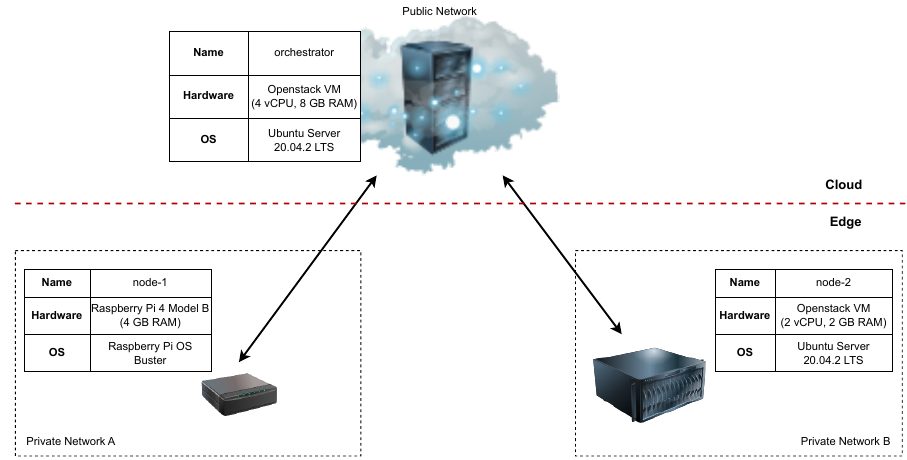
Figure 6. Configuration of the evaluation